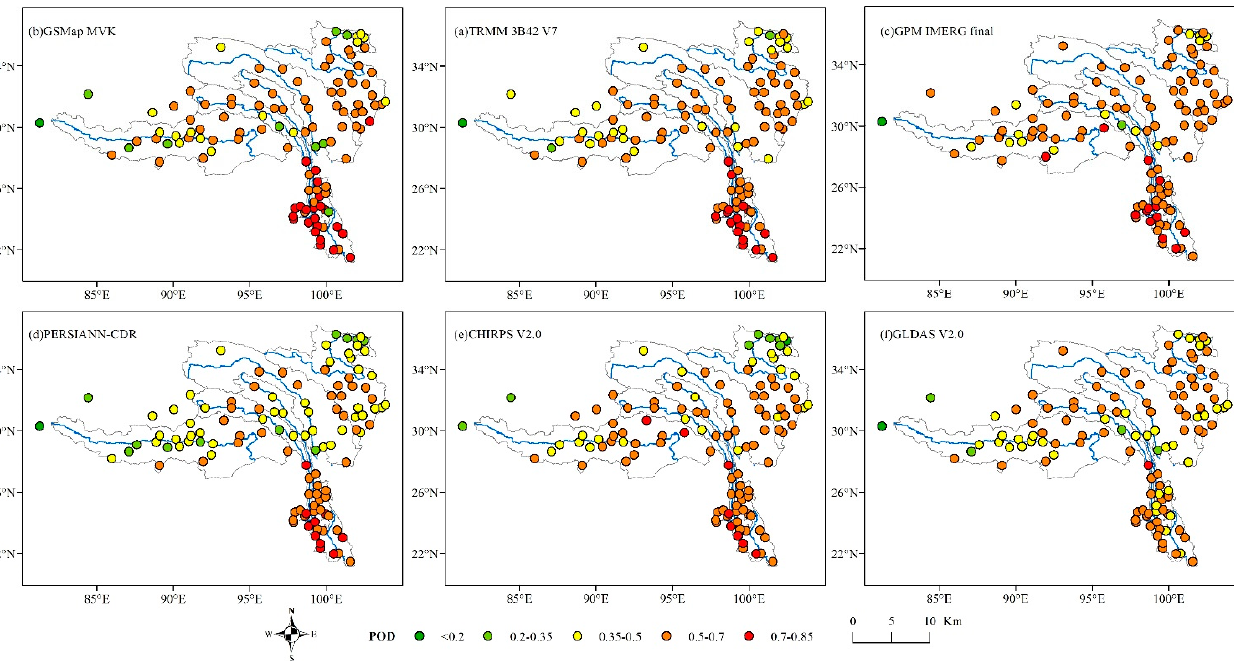
Figure 9. The POD between different rain gauges and corresponding grids in data products.